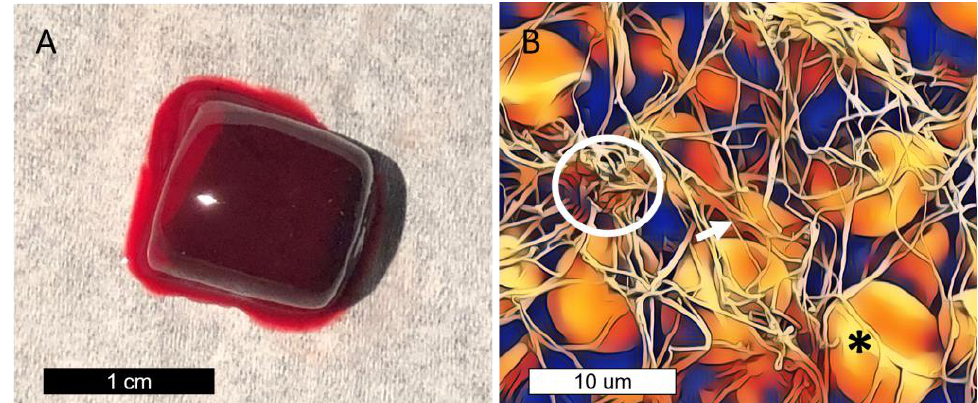
Figure 1. ( A ) Bulk appearance of a clot after ex vivo development in a serum separator tube and subsequent washing. Clots formed are several millimeters in size. ( B ) Colorized scanning electron microscopy (SEM) image of a clot demonstrating the fibrin lattice (arrow), erythrocytes (asterisk), and platelets (circle).